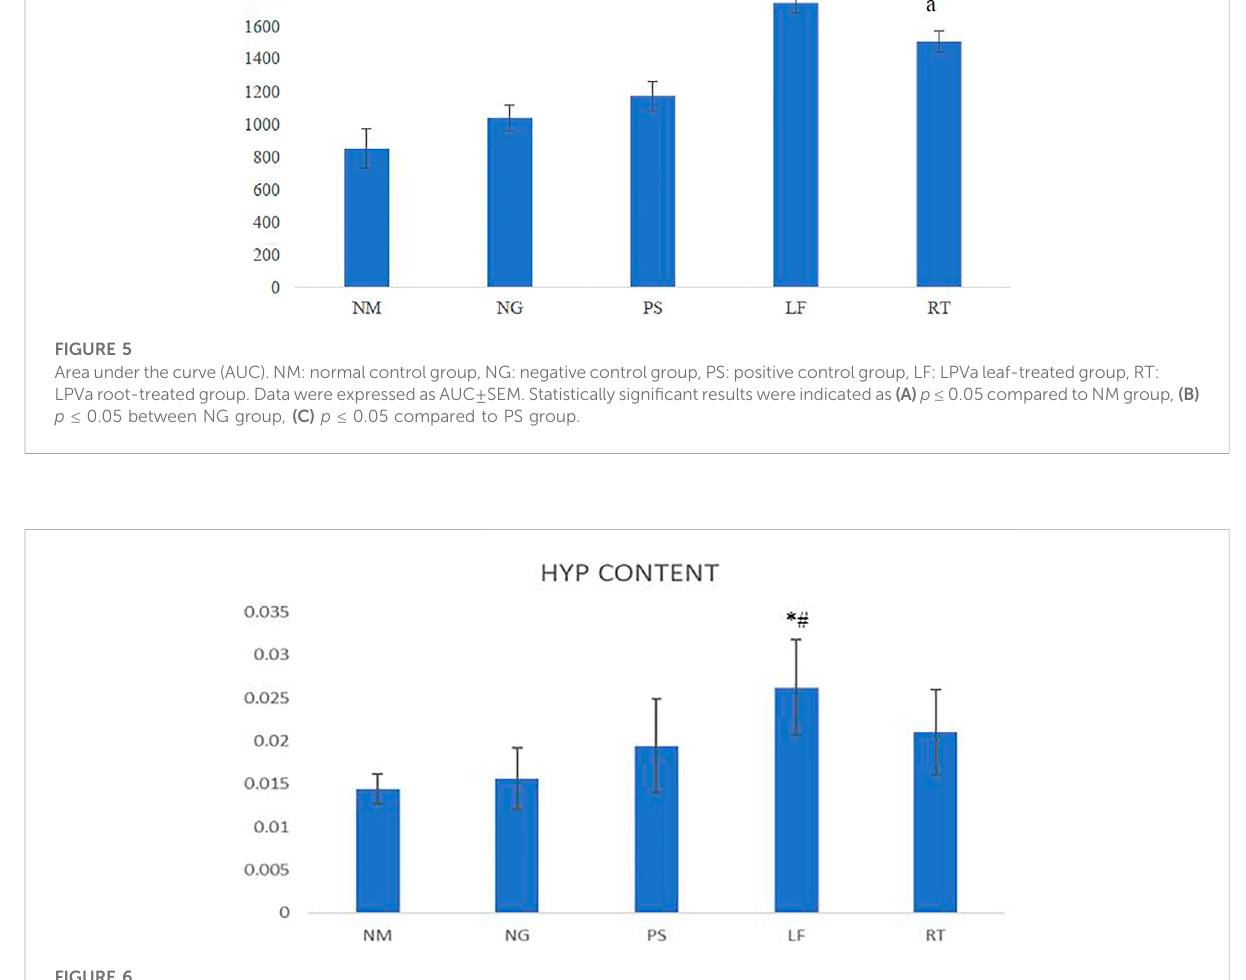
FIGURE 6 Hydroxyproline contents for wounds Statistically signi fi cant difference were indicated as * p ≤ 0.05 between NM group and # p ≤ 0.05 between NG group. NM: normal control group, NG: negative control group, PS: positive control group, LF: LPVa leaf-treated group, RT: LPVa root-treated